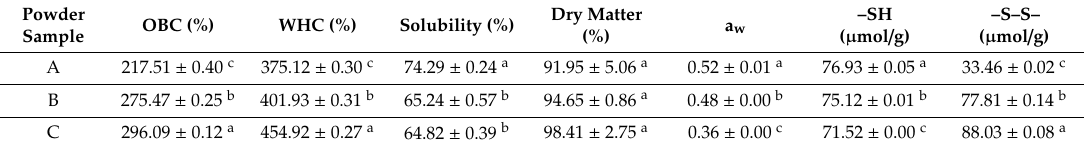
Table 2. Oil-binding capacity (OBC), water-holding capacity (WHC), solubility, dry matter, water activity (a w ), and sulfhydryl group (–SH) and disulfide bond (–S–S–) contents of FOCE powders. Powder Sample